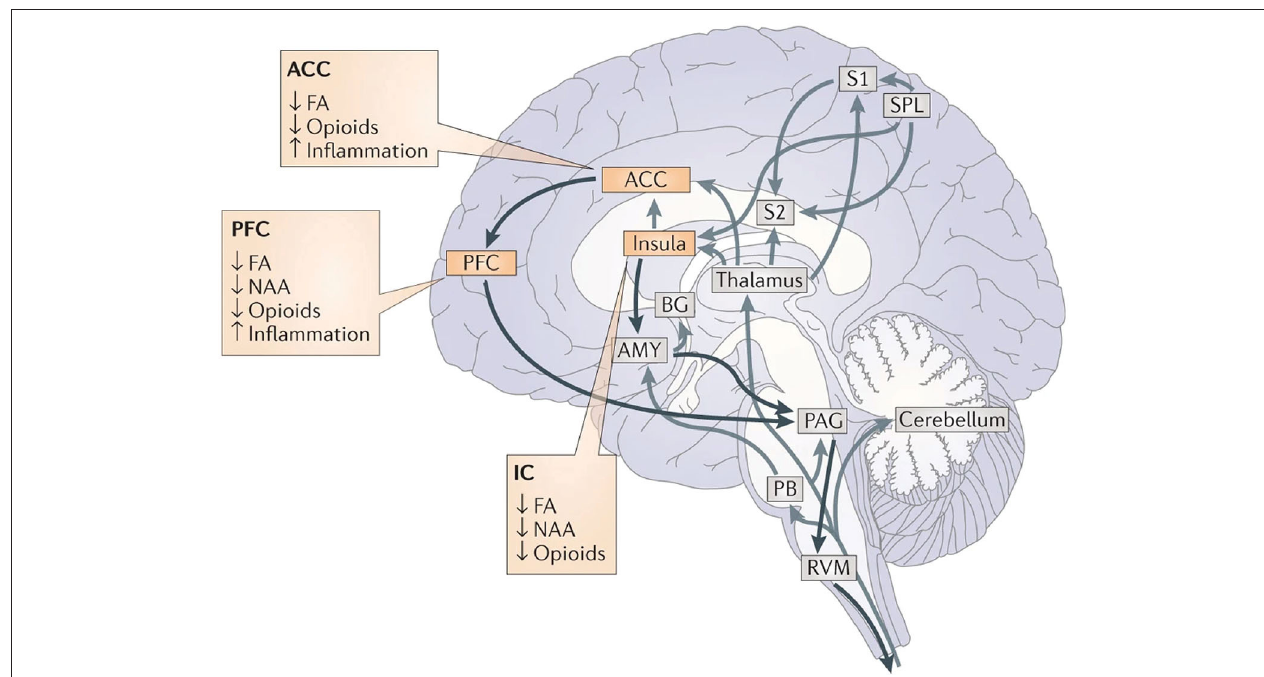
FIGURE 14 | Consistent patterns of chronic pain.The ACC, PFC, and IC consistently display decreased grey matter in chronic pain conditions, along with impaired white matter health (FA) and opioid receptor binding. Chronic pain is also associated with reductions in N-acetyl aspartate in the ACC and PFC, while studies in rodents have found increased inflammation in these regions as well. Reprinted with permission from Springer Nature Customer Service Centre GmbH: Springer Nature, Nature Reviews Neuroscience, Vol 14, Cognitive and emotional control of pain and its disruption in chronic pain, MC Bushnell, M Ceko, LA Low, p502–11, Copyright (2013). DOI: https://doi.org/10.1038/nrn3516. Grey arrows, pain pathways; Black arrows, descending pathways; FA,functional anisotropy: a measure of molecule diffusion that serves as an index of white matter integrity; Opioids, opioid receptor binding: a marker of the ability to bind opioids and a way to analyze the health of descending pain systems; NAA, N-acetyl aspartate: a marker of neuronal viability. ACC, anterior cingulate cortex; PFC, prefrontal cortex; IC, insular cortex; S1, primary somatosensory cortex; S2, secondary somatosensory cortex; SPL, superior parietal lobe; BG, basal ganglia; AMY, Amygdala; PAG, periaqueductal gray; PB, parabrachial nuclei; RVM, rostral ventromedial